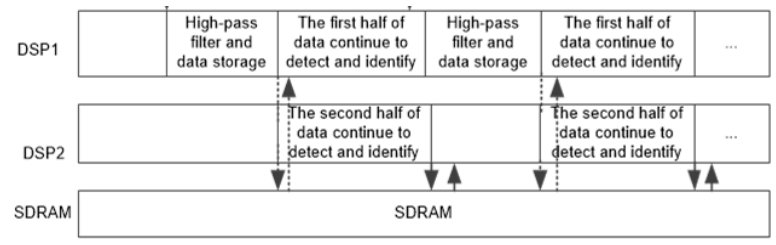
Figure 10. Structure diagram of parallel processing.